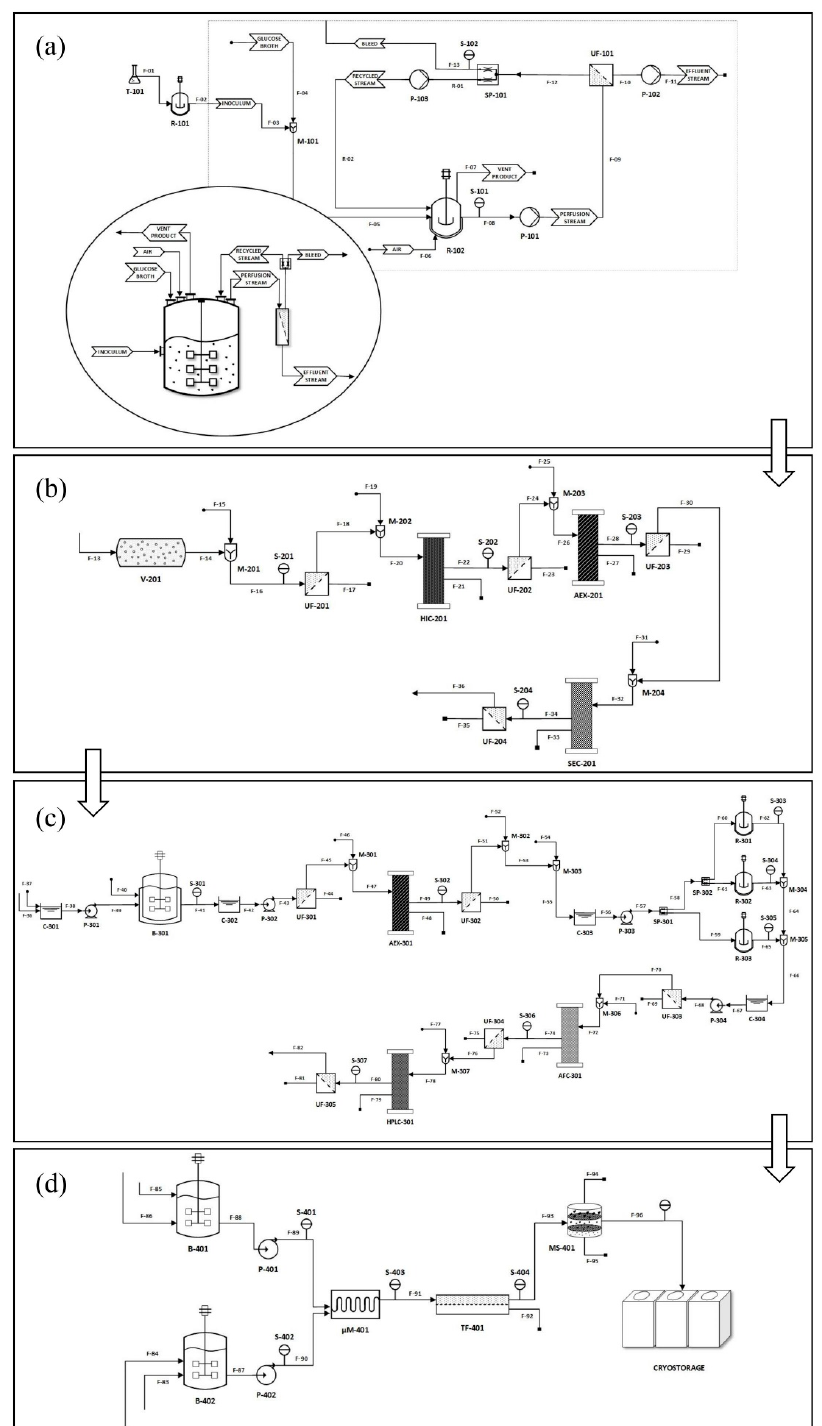
Figure 3. Process flow diagram of the Pharma 4.0, GMP compliant mRNA production ( a ) perfusion bacterial culture upstream; ( b ) cell lysis and plasmid purification; ( c ) linearization and in vitro transcription; ( d ) lipid nanoparticle microfluidic formulation [43].